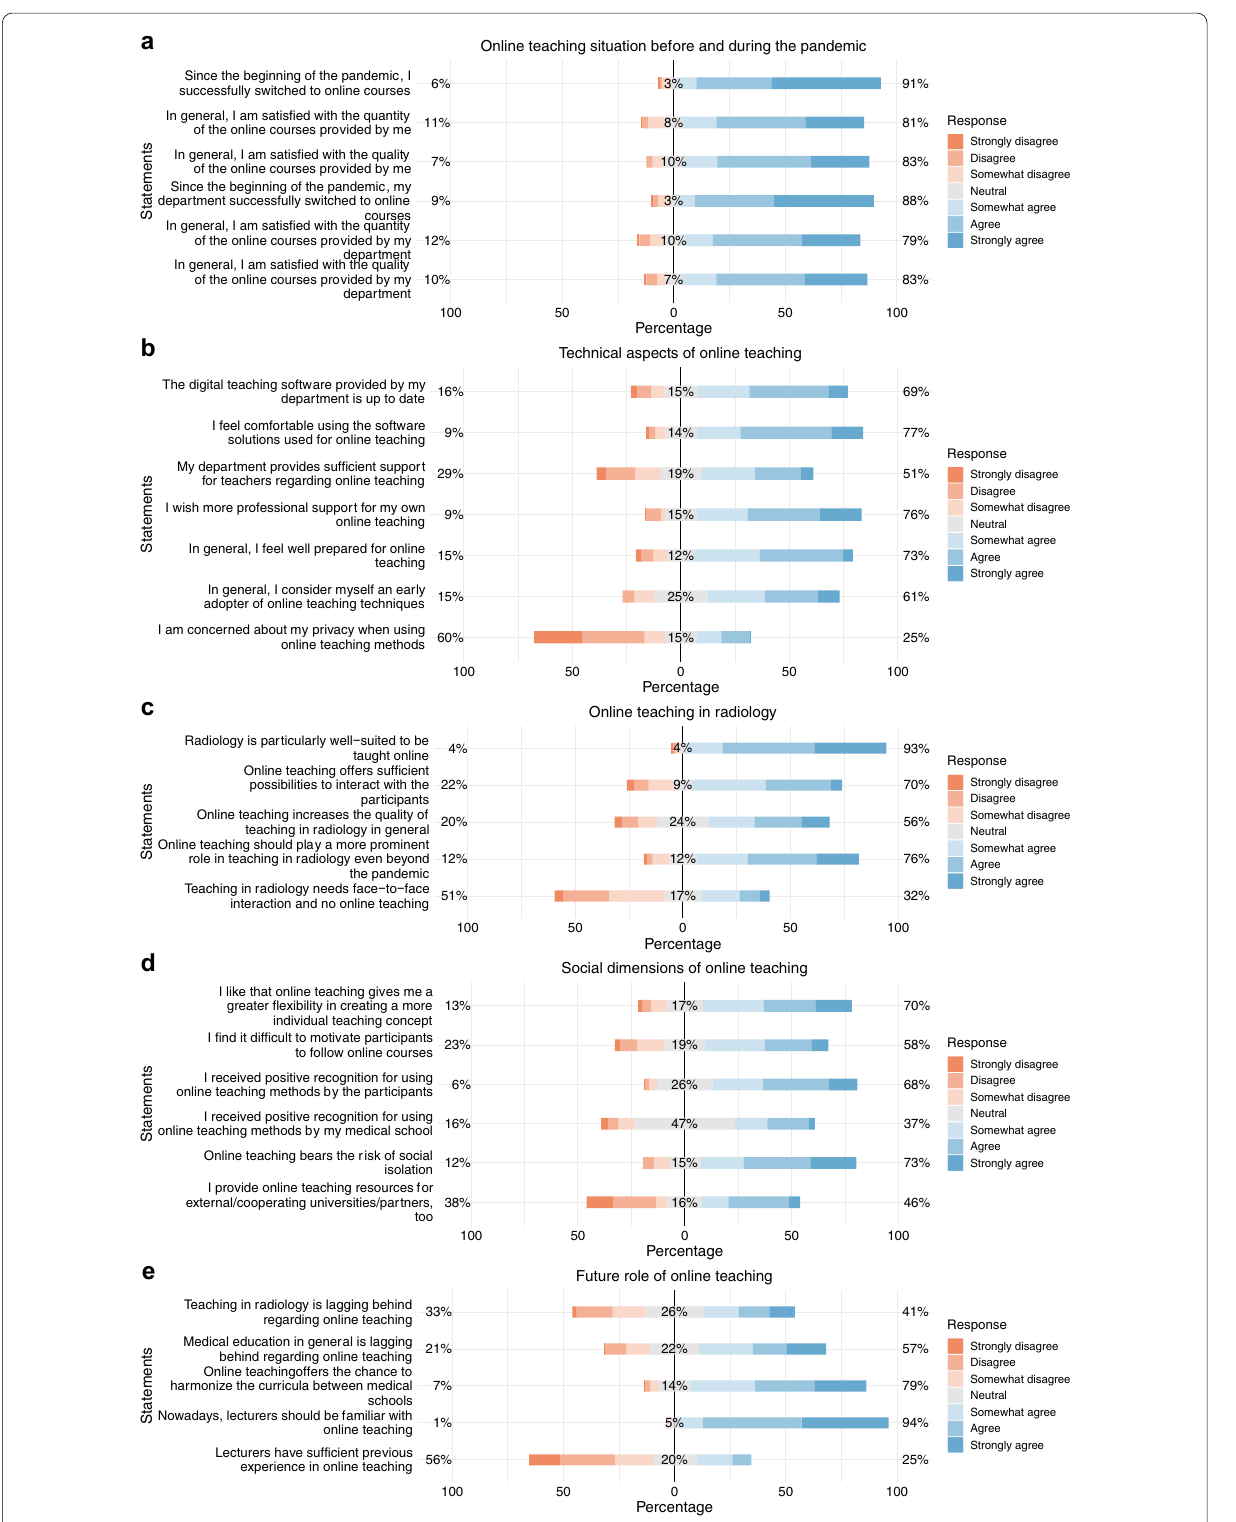
Fig. 1 Detailed responses regarding “online teaching situation before and during the pandemic” ( a ), “technical aspects of online teaching” ( b ), “online teaching in radiology” ( c ), “social dimensions of online teaching” ( d ), and “future role of online teaching” ( e ). Orange represents “disagreement,” gray represents “neutral,” whereas blue represents